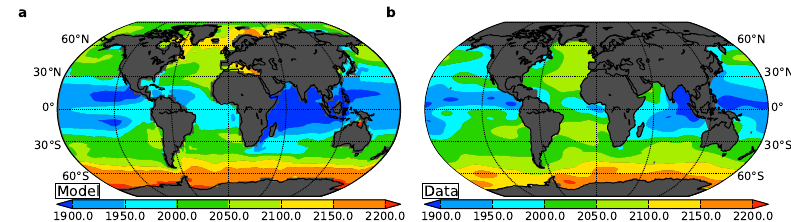
Figure 13. Dissolved inorganic carbon (DIC) distribution at the ocean surface (µmolkg − 1 ). Data from GLODAP (Key et al., 2004).